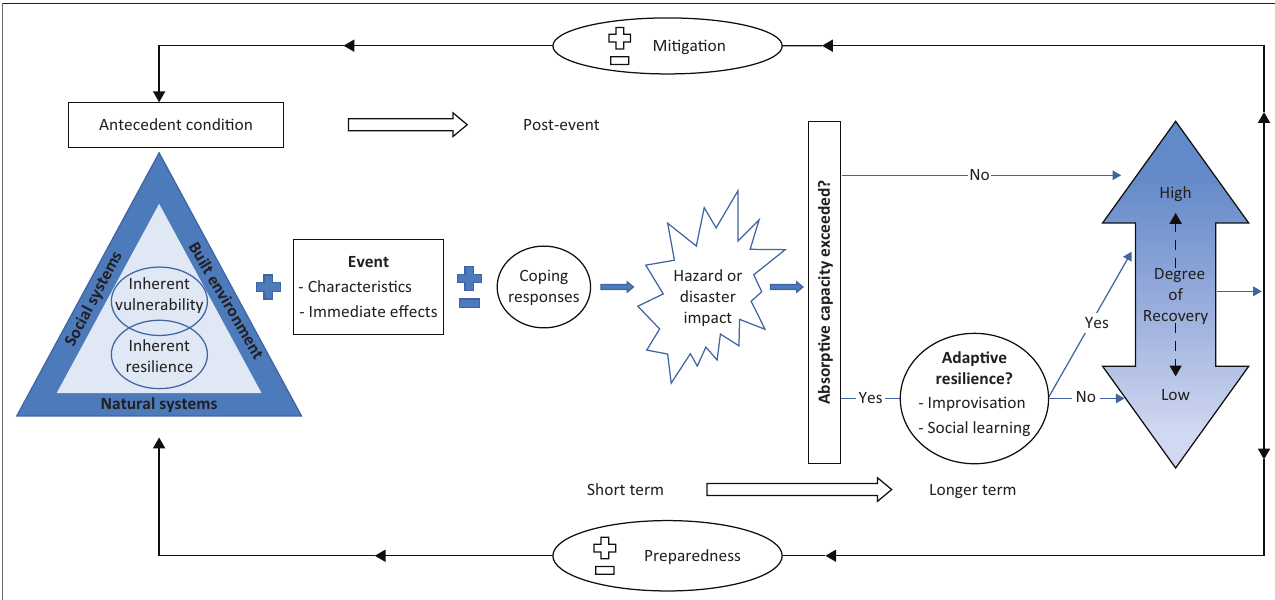
FIGURE 2: The disaster resilience of place